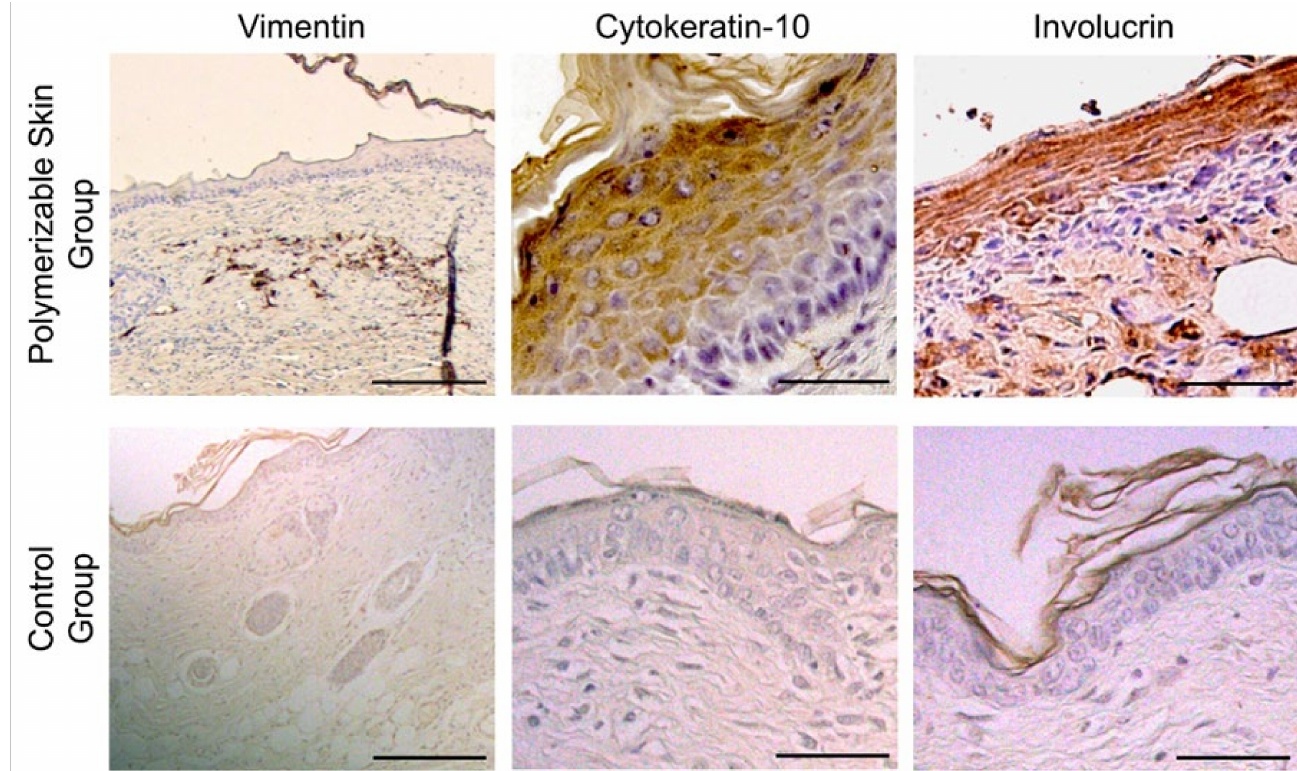
Figure 4. Immunohistochemistry study of the regenerated skin in athymic mouse. 21 days after treatment with the polymerizable skin hydrogel, the human regenerated skin showed positive labelling for involucrin and cytokeratin 10 in the suprabasal layers. Vimentin labelled full thickness of human dermis and some cells located into the dermis of the grafted area. Scale bars: 50 µ m. Vimentin scale bar: 200 µ m. In the control group (hydrogel without human cells) wound closure is achieved by murine cells from the wound edges. Biopsies from the treated area showed no labelling for the antibodies